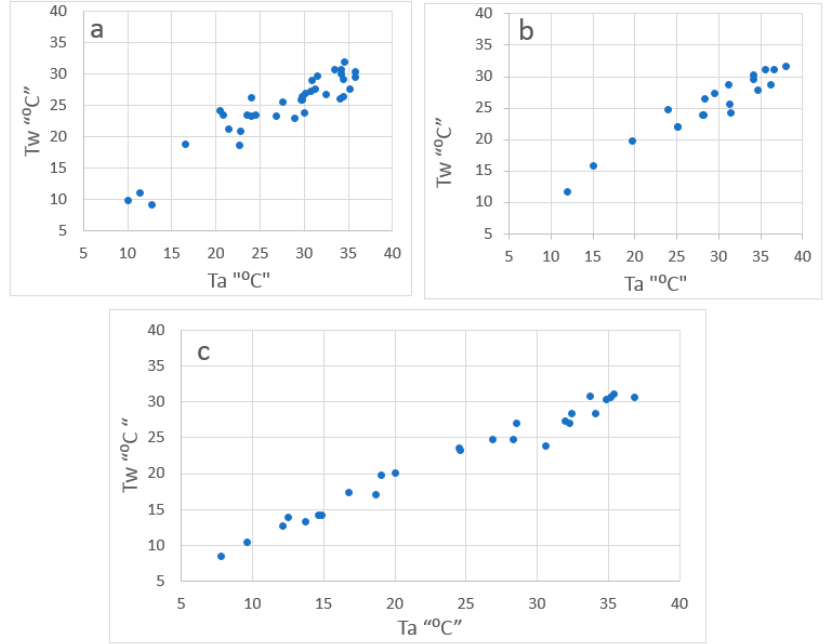
Figure 4. Satellite T w and 5 days weighted average of air temperature T a at Mosul Dam (sample size 36), Beaji (sample size 20), and Baghdad (sample size 26). ( a ) Mosul, ( b) Baeji, and( c ) Baghdad.